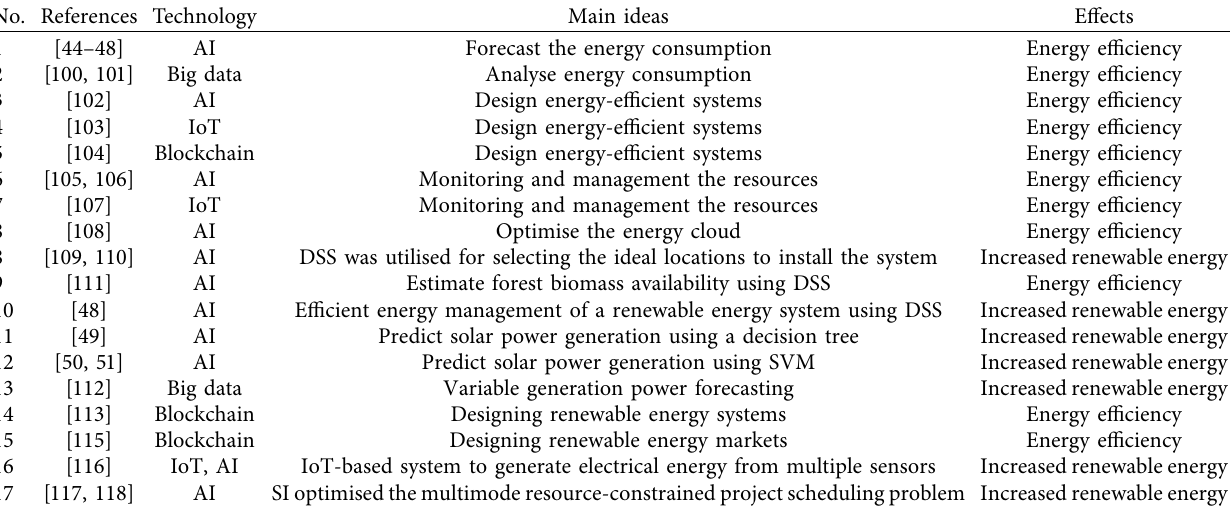
Table 5: Applications of digital solution in sustainable resource